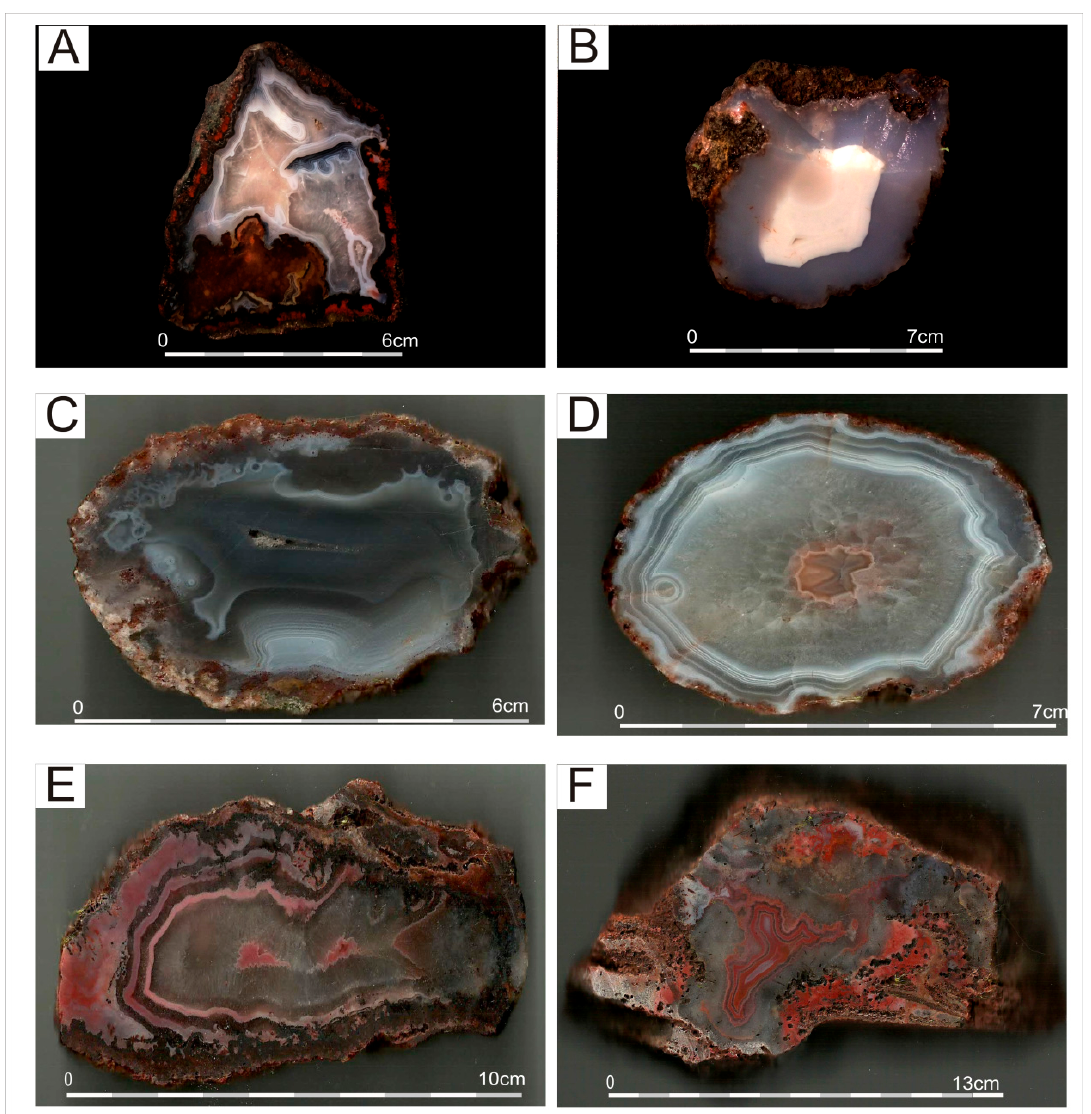
Figure 2. Macrophotographs of examined Moroccan agates: ( A , B ) Agates from Asni showing either polycentric (A) or monocentric fabrics (B). Note the presence of black and red-colored pigments distributed along the external margin of the geode made of polycentric agate. ( C , D ) Monocentric agates from Aguoim marked by wall-lining arrangement of alternating dark and light-colored chalcedonic bands (C). Note the occurrence of a well-developed quartz-rich center (D), as well as abundant hematite pigments distributed along particular chalcedonic layers ( E , F ).